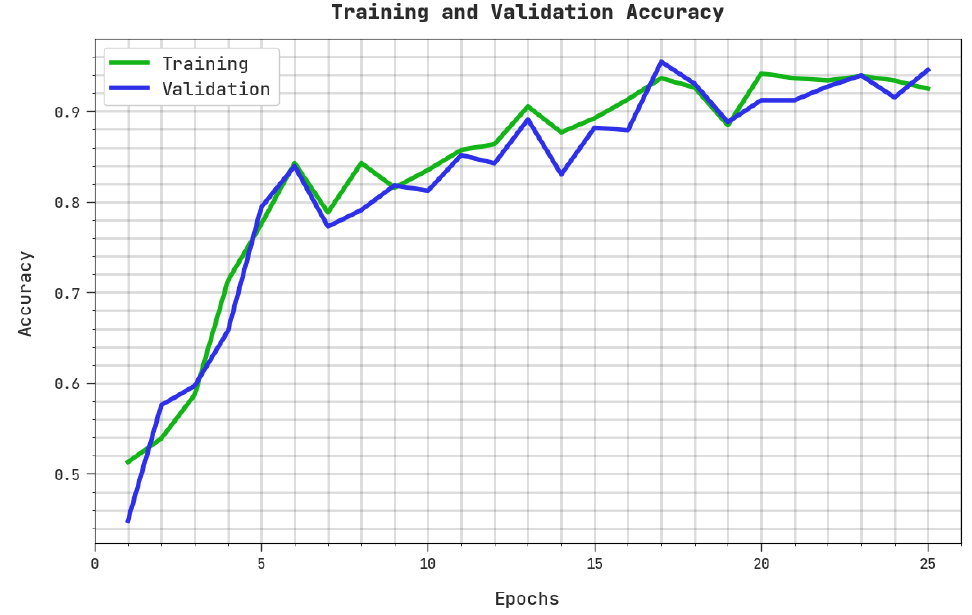
Figure 6. TRA and VLA analysis ASODCAE-SLR approach. The training loss (TRL) and validation loss (VLL) accomplished by the ASODCAE- SLR system on the test dataset are depicted in Figure 7. The experimental result revealed that the ASODCAE-SLR approach has obtained minimal values of TRL and VLL. Cer- tainly, the VLL is lesser than TRL.